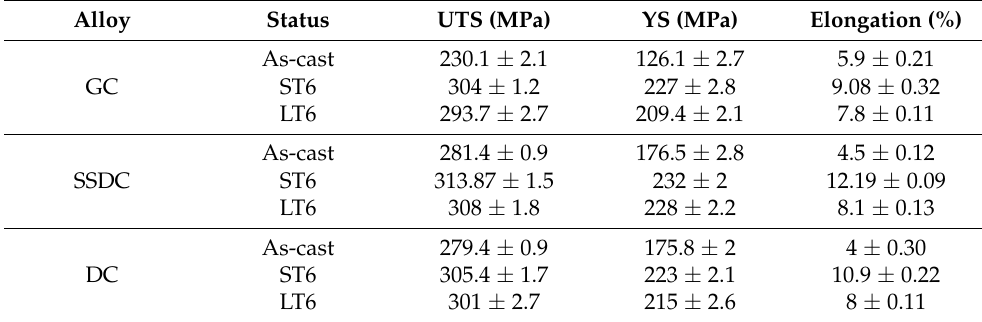
Figure 4. Mechanical properties of the alloys: ( a ) UTS, ( b ) YS, ( c ) Elongation. Table 3. Mechanical properties of the